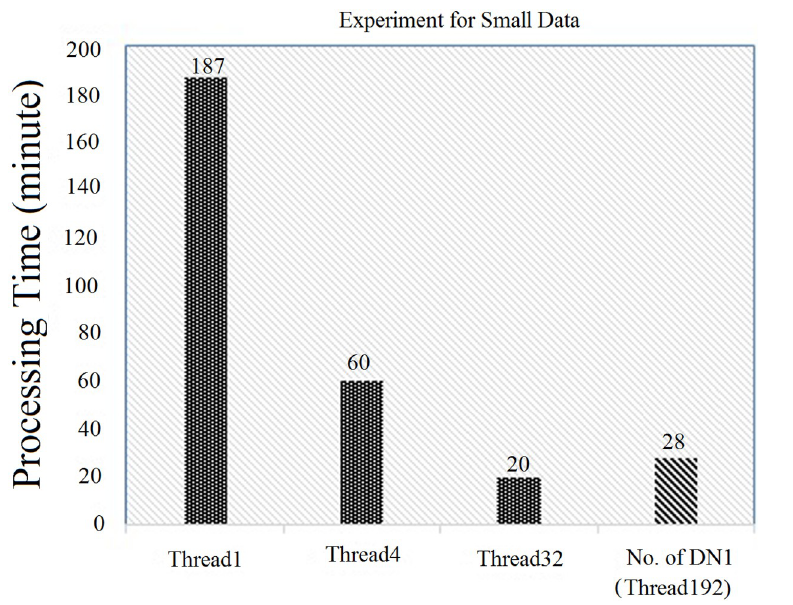
Fig 16. Experiment using single DataNode with 192 threads.